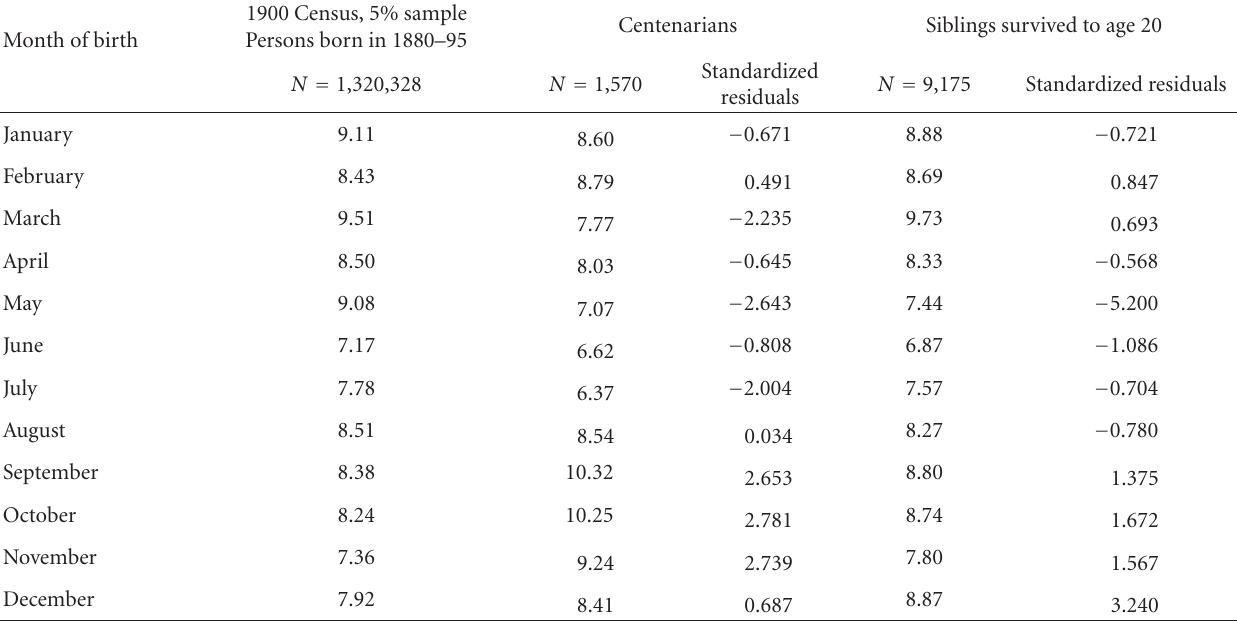
Table 4: Month-of-birth distributions (in percent) for the US 1900 Census population, centenarians, and their siblings a .